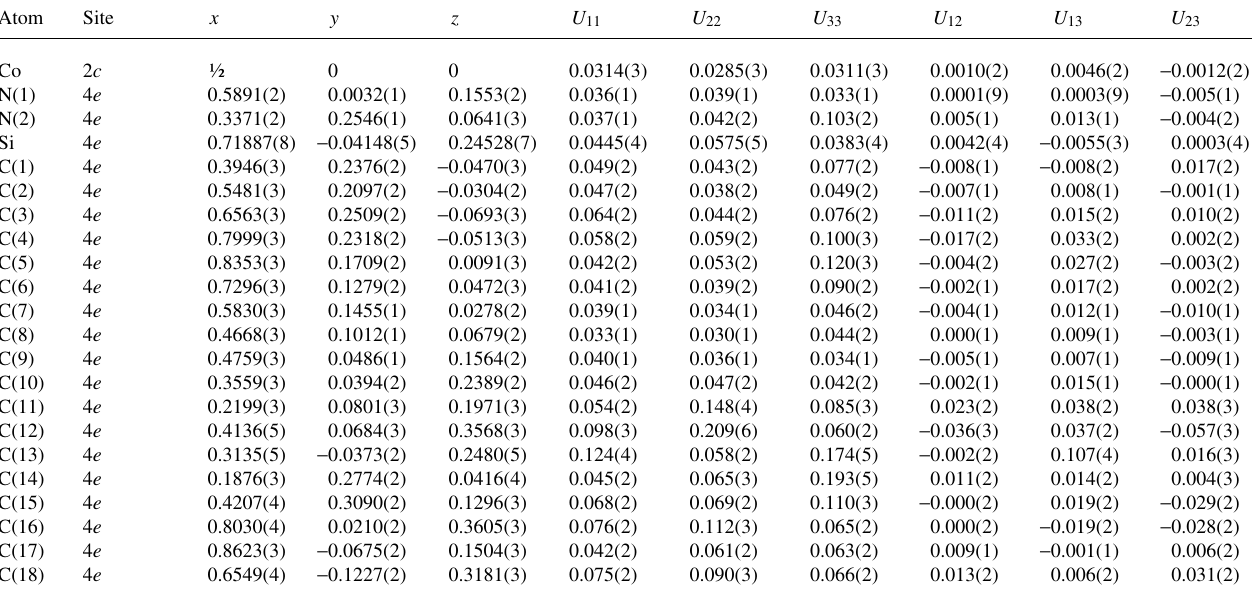
Table 3. Atomic coordinates and displacement parameters (in Å 2 )